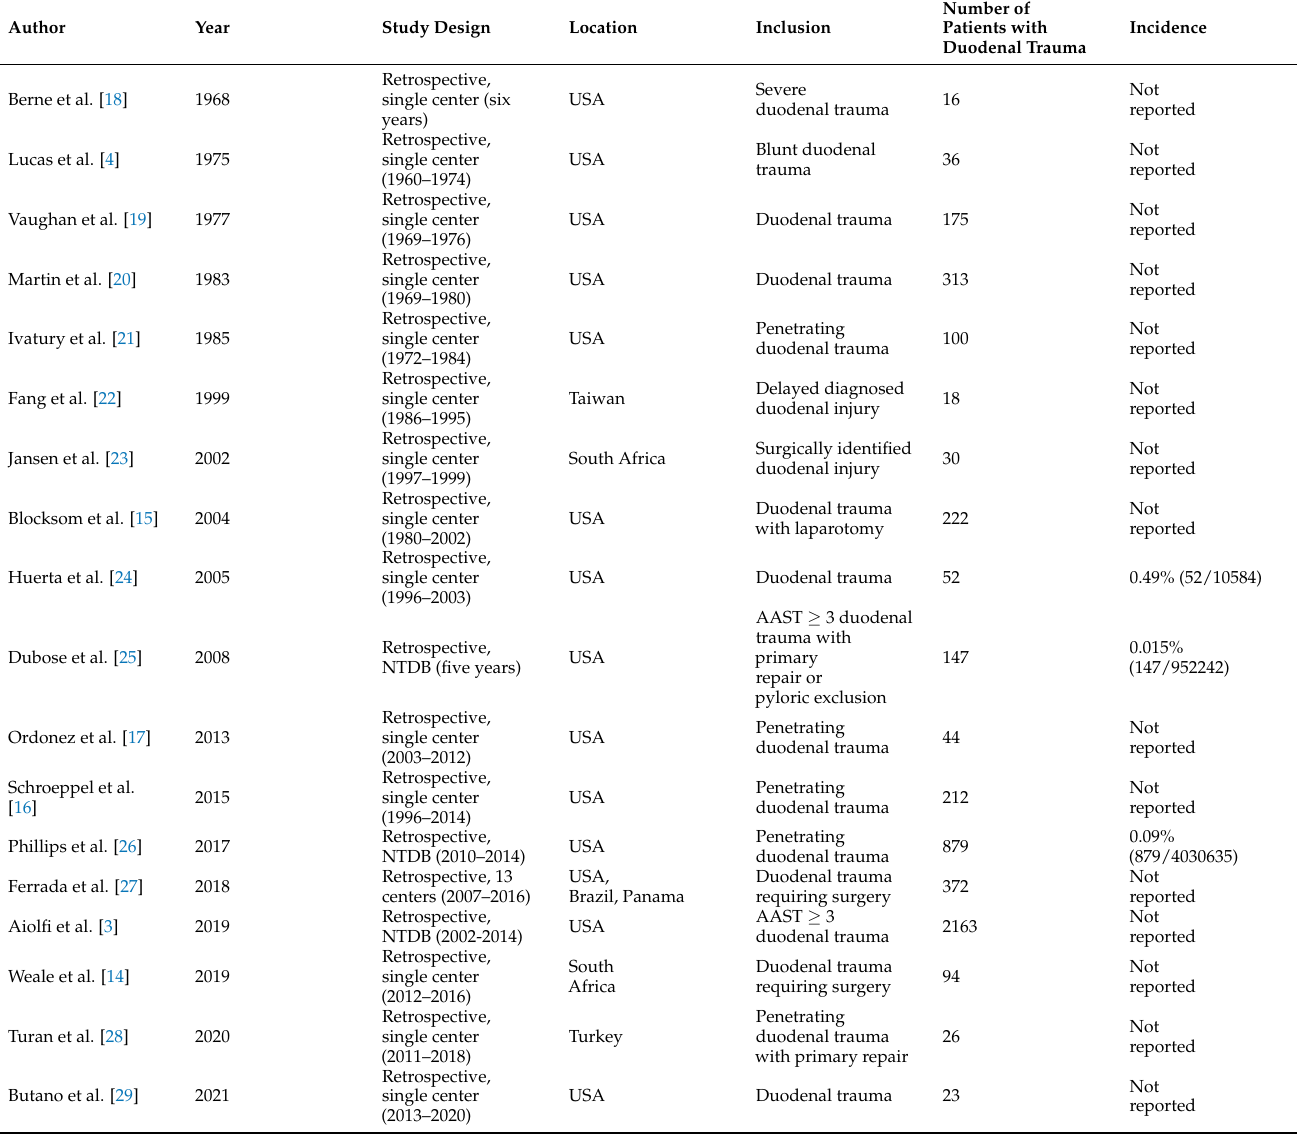
Table 5. Literature review of duodenal